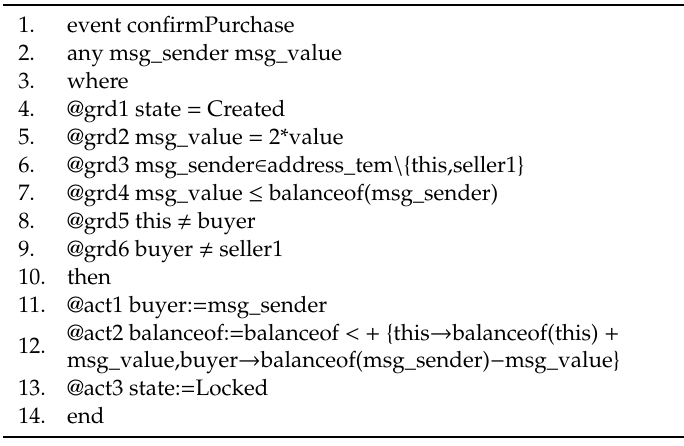
Table 3. Event “confirmPurchase” of the Event-B